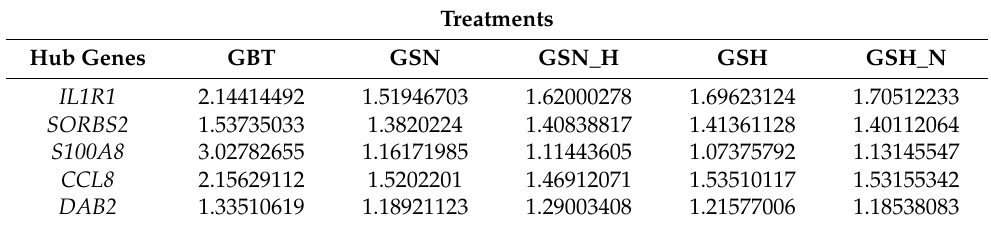
Table 5. The five most significant hub genes by average expression values in log 2 base for each treatment.